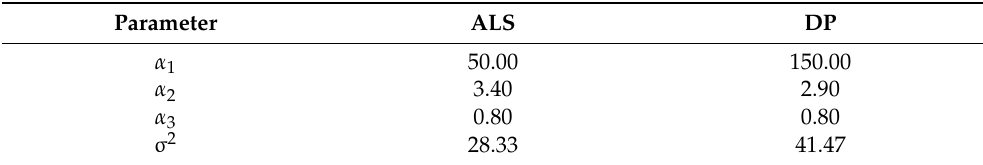
Table 1. Input parameters for simulating the relationship between GSV and RS metrics according to Equation (1).